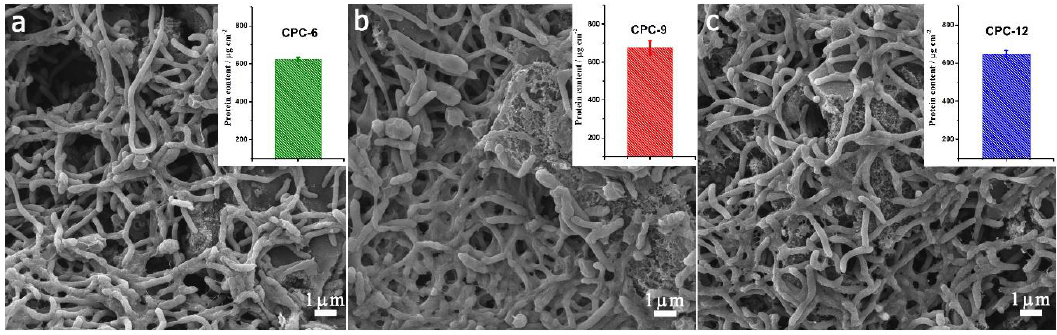
Figure 7. Morphologies of different anodes after two cycles of MFCs operation. ( a ): CPC-6; ( b ): CPC-9;